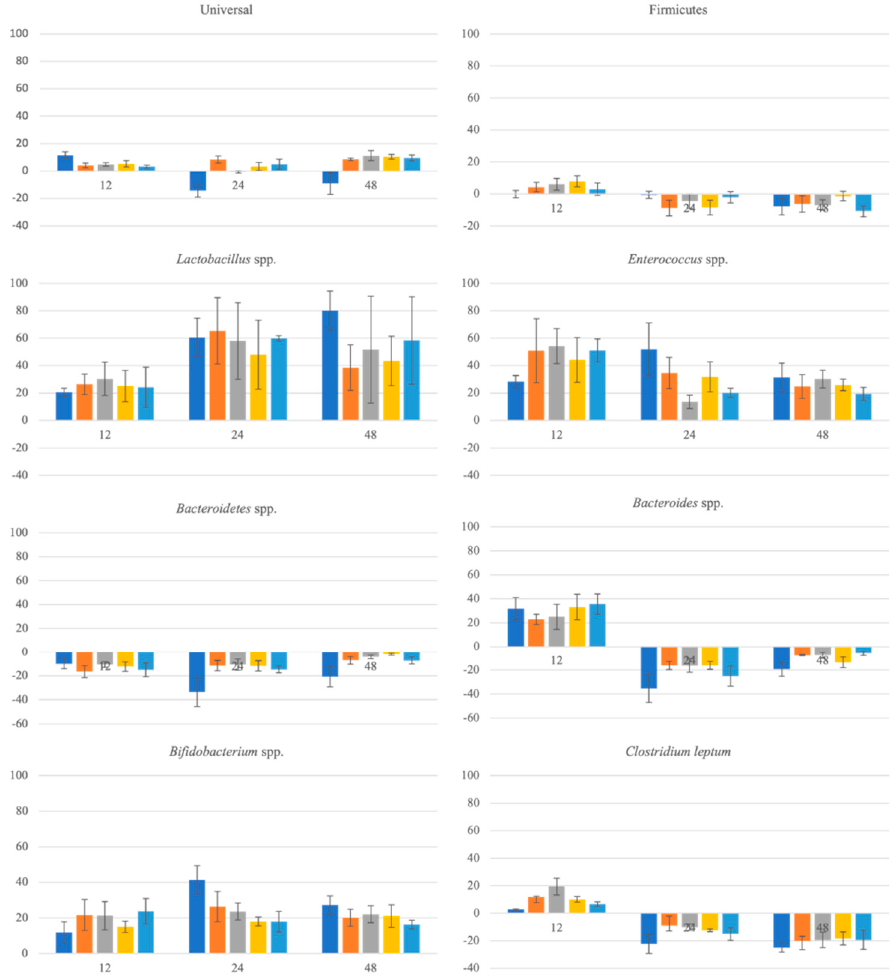
Figure 4. Evolution of the gut microbiota groups (relative differences to the negative control in %). ■ —FOS; ■ —60% ethanol:water SLE; ■ —80% ethanol:water SLE; ■ —60% ethanol:water OHE; ■ —80% ethanol:water OHE.